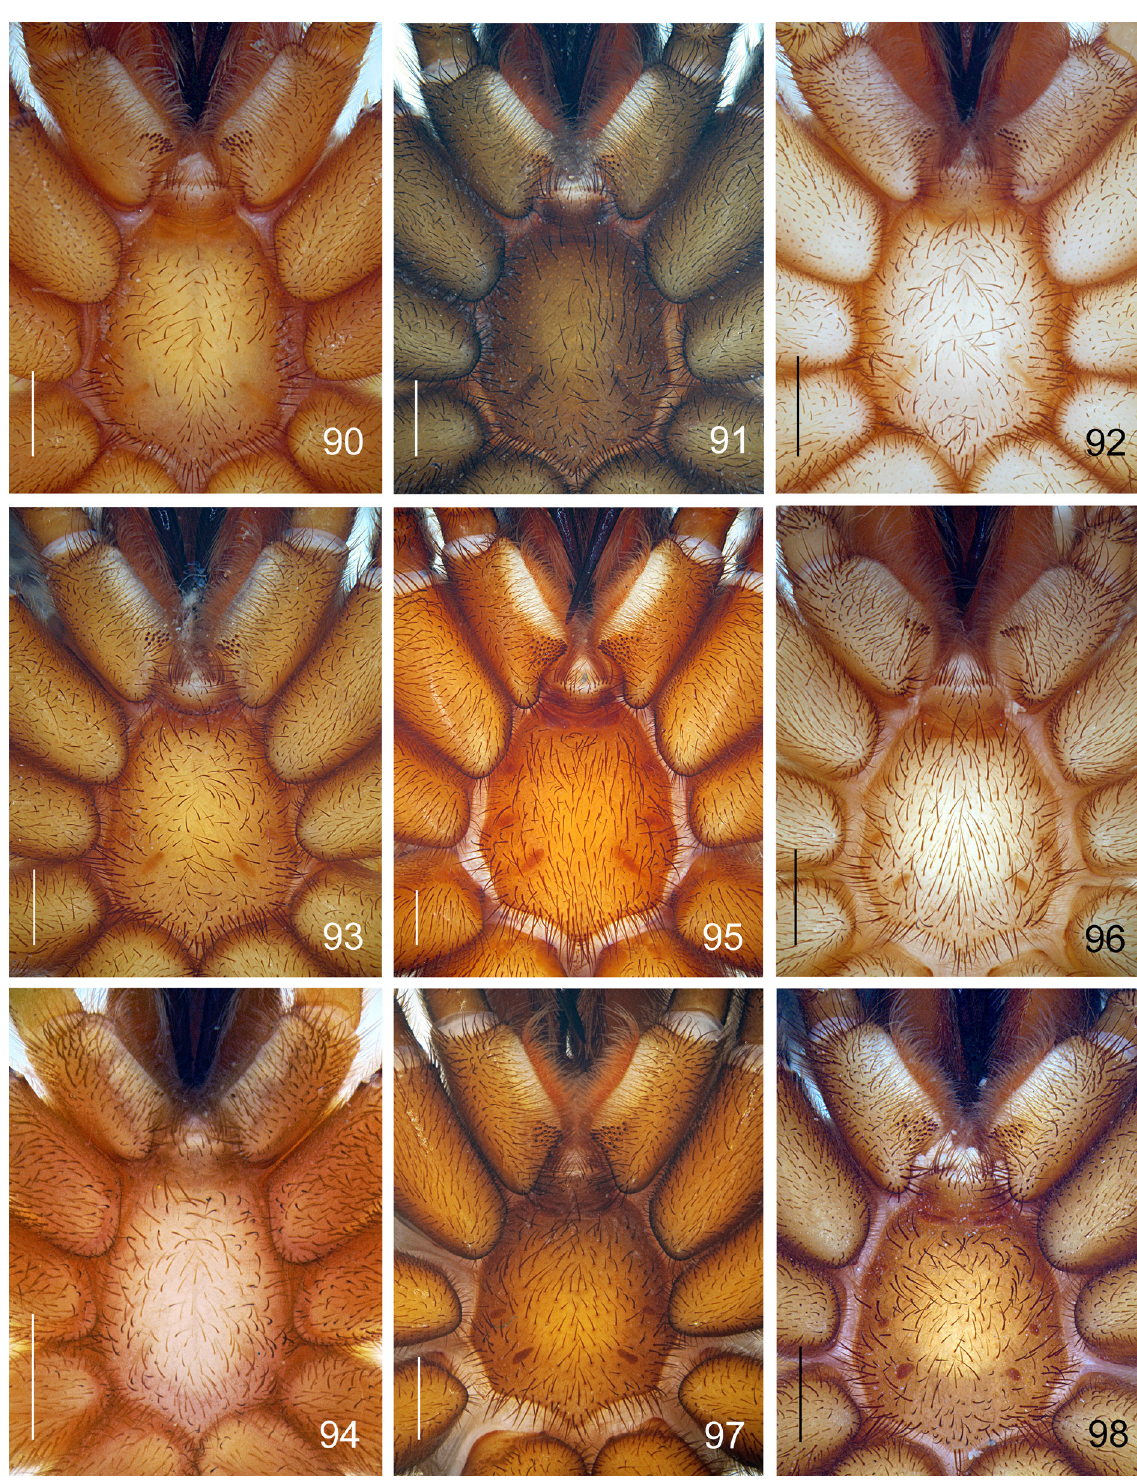
Figs 90–98. Anemesia spp., ♂♂, sternum, labium and maxillae, ventral views. 90 . A. birulai (Spassky, 1937) (holotype). 91 . A. koponeni Marusik, Zamani & Mirshamsi, 2014 (holotype). 92 . A. pococki sp. nov. (holotype). 93 . A. tubifex (Pocock, 1889) (Kalaimor). 94 . A. andreevae sp. nov. (holotype). 95 . A. oxiana sp. nov. (holotype). 96 . A. sogdiana sp. nov. (holotype). 97 . A. castanea sp. nov. (holotype). 98 . A. karatauvi (Andreeva, 1968) (Hojamaston). Scale bars: 1.0